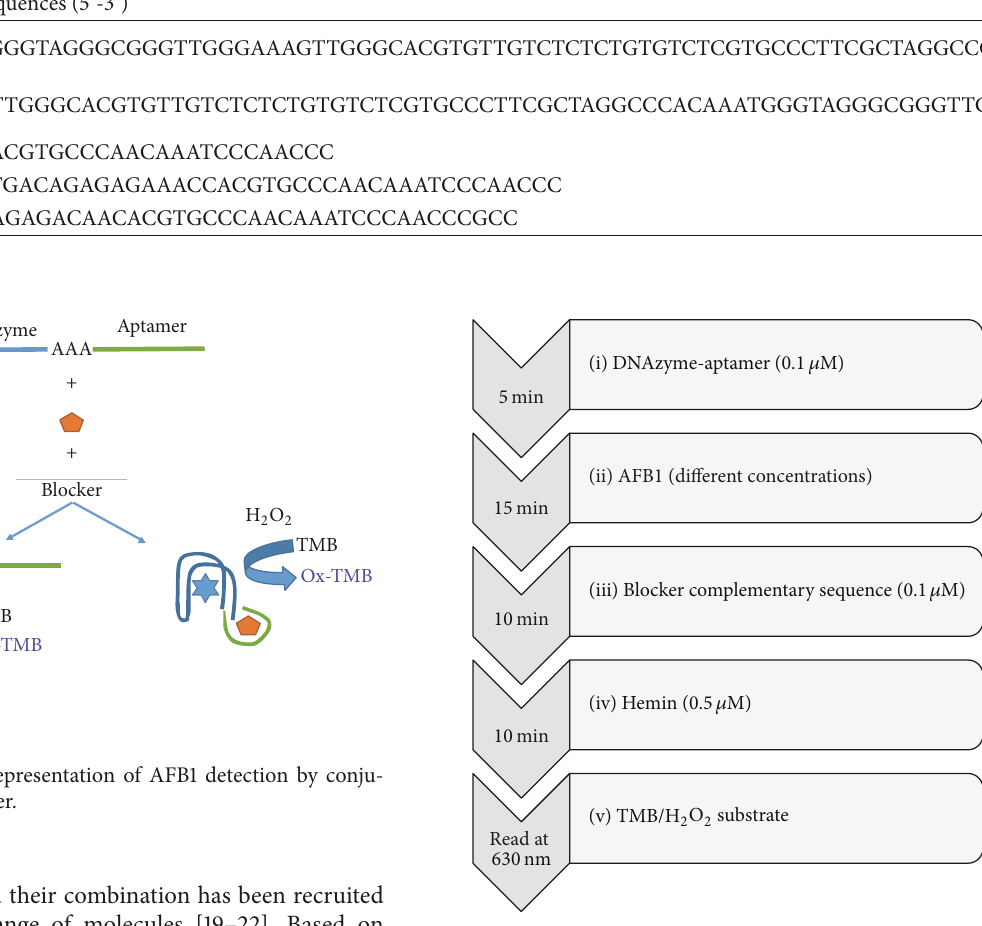
Scheme 2: Schematic representation for optimized assay